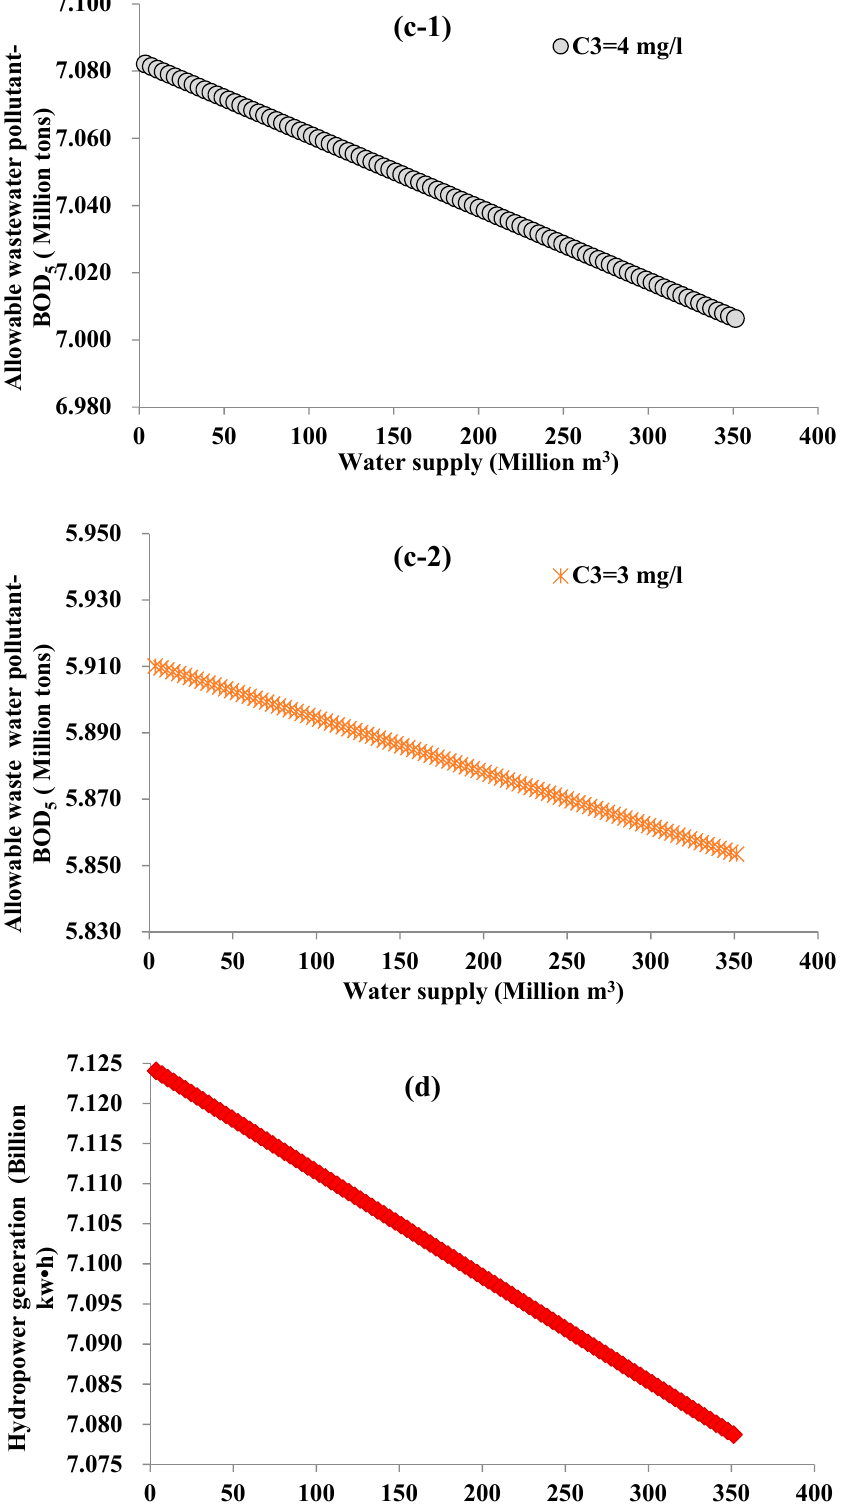
Figure 6. The nexus between water supply and allowable wastewater pollutant under the inflow frequency level p = 75%: ( a ) for NH3-N with Class III ( C 3 = 1.0 mg / L) water quality protection target, ( b ) for NH3-N with Class I ( C 3 = 0.5 mg / L)water quality protection target, ( c-1 ) and ( c-2 ) for BOD5 with Class III ( C 3 = 4.0 mg / L) and I ( C 3 = 3.0 mg / L) water quality protection targets, respectively, and ( d ) for the nexus between water supply and hydropower generation.